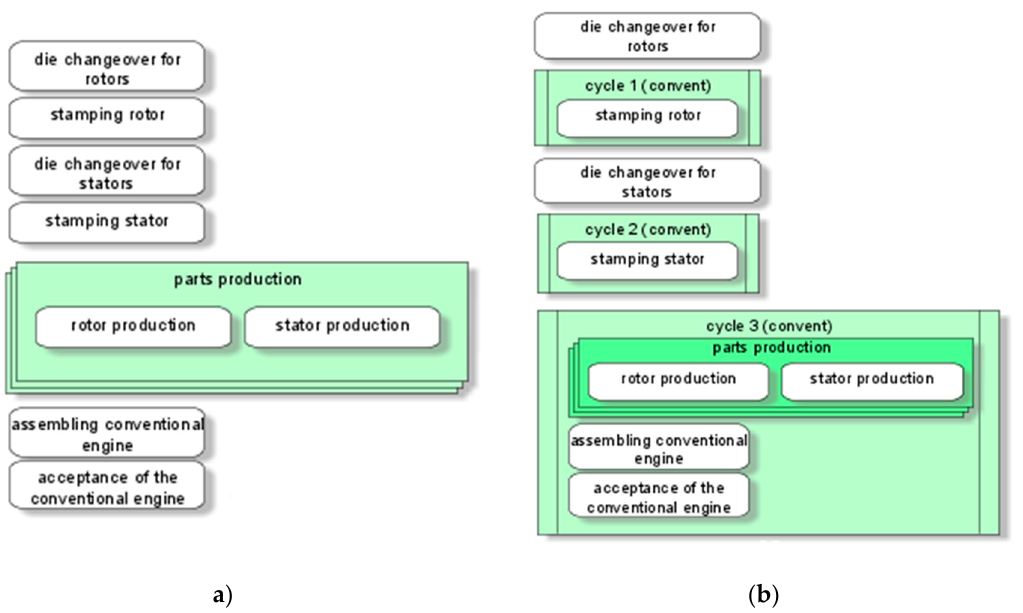
Figure 7. Diagrammatic ARIS models version 1 to estimate system dynamic capability indicator for